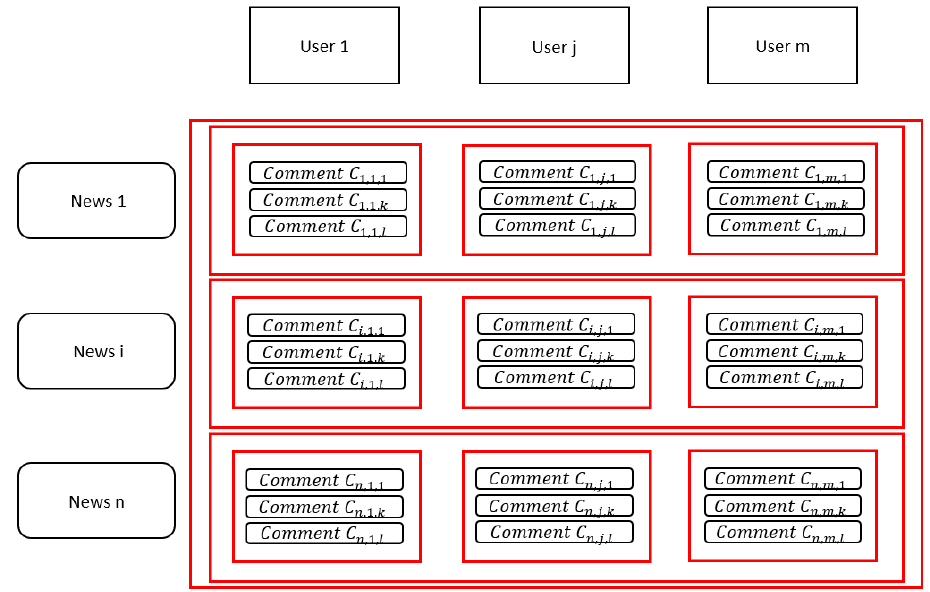
Figure 4. Method to evaluate similarity of each user’s comments to other users’ comments .